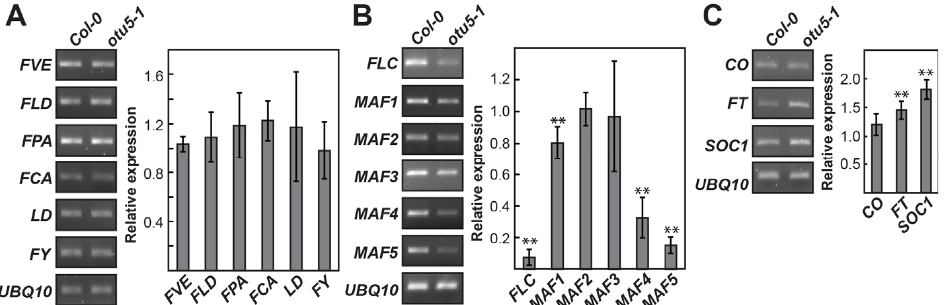
Figure 3. Expression of various flowering regulators and autonomous pathway components in otu5-1 plants. Expression levels in Col-0 and otu5-1 seedlings of 10 (RT-PCR) or 14 DAS (RT-qPCR) for major autonomous pathway components, including FVE , FLOWERING LOCUS D , FPA , FCA , LUMINIDEPENDENS , and FY ( A ), major flowering repressors FLC and FLC -related flowering repressors MAF1-5 ( B ), and major flowering activators CO , FT , and SOC1 ( C ) were examined by RT-PCR (left panels) and RT-qPCR (right panels). UBQ10 was used as a control. ** p < 0.01, significance of expression levels for various flowering regulators in otu5-1 were compared with those in Col-0 using Student’s t -test.